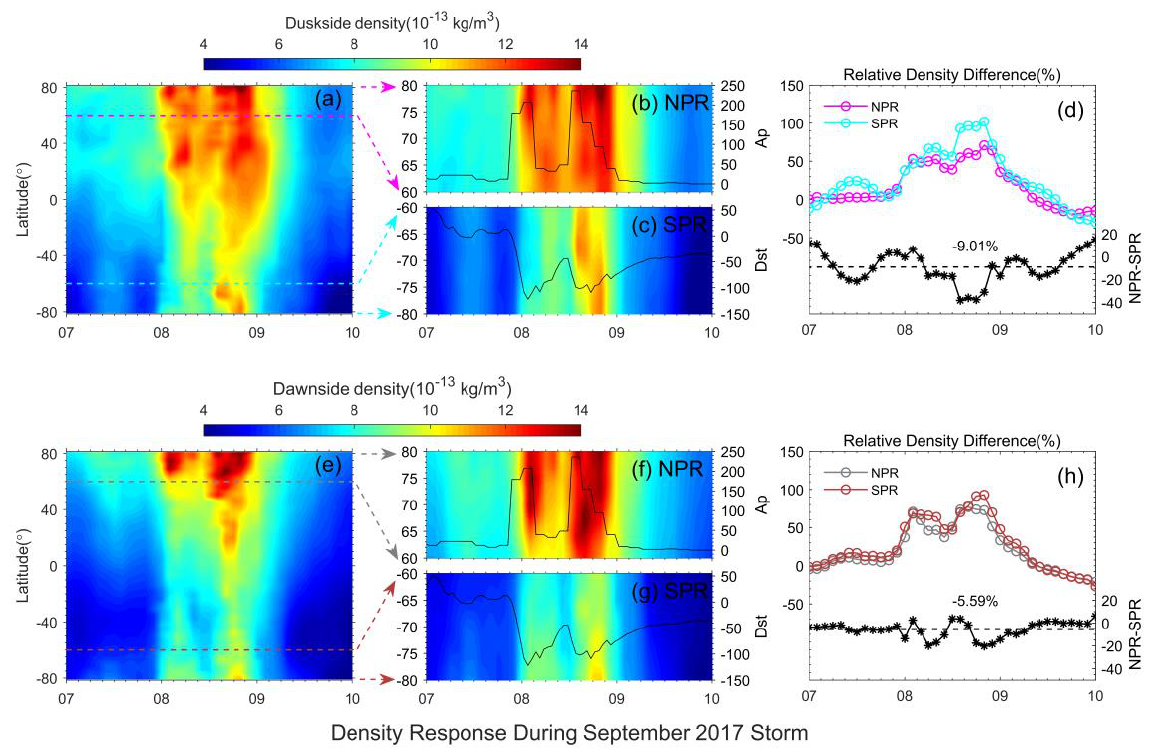
Figure 3. Thermospheric density response during the geomagnetic storm from 7 to 10 September 2017. Panels ( a , e ) display the global distribution of thermospheric density variations with UT and latitude on the dusk- and dawnside, respectively. Panels ( b , c ) show the density latitudinal profiles for the northern polar region (NPR, above 60 ◦ N) and southern polar region (SPR, above 60 ◦ S) on the duskside, with corresponding black lines indicating the Ap and Dst geomagnetic indices. Similarly, panels ( f , g ) display the density latitudinal profiles for the NPR and SPR on the dawnside. Panels ( d , h ) show the relative density difference on the duskside and dawnside, respectively, with the colored lines indicating the relative density difference for the NPR and SPR and the black line indicating the difference in relative density difference between the NPR and SPR, with the mean difference also labeled on the plot.